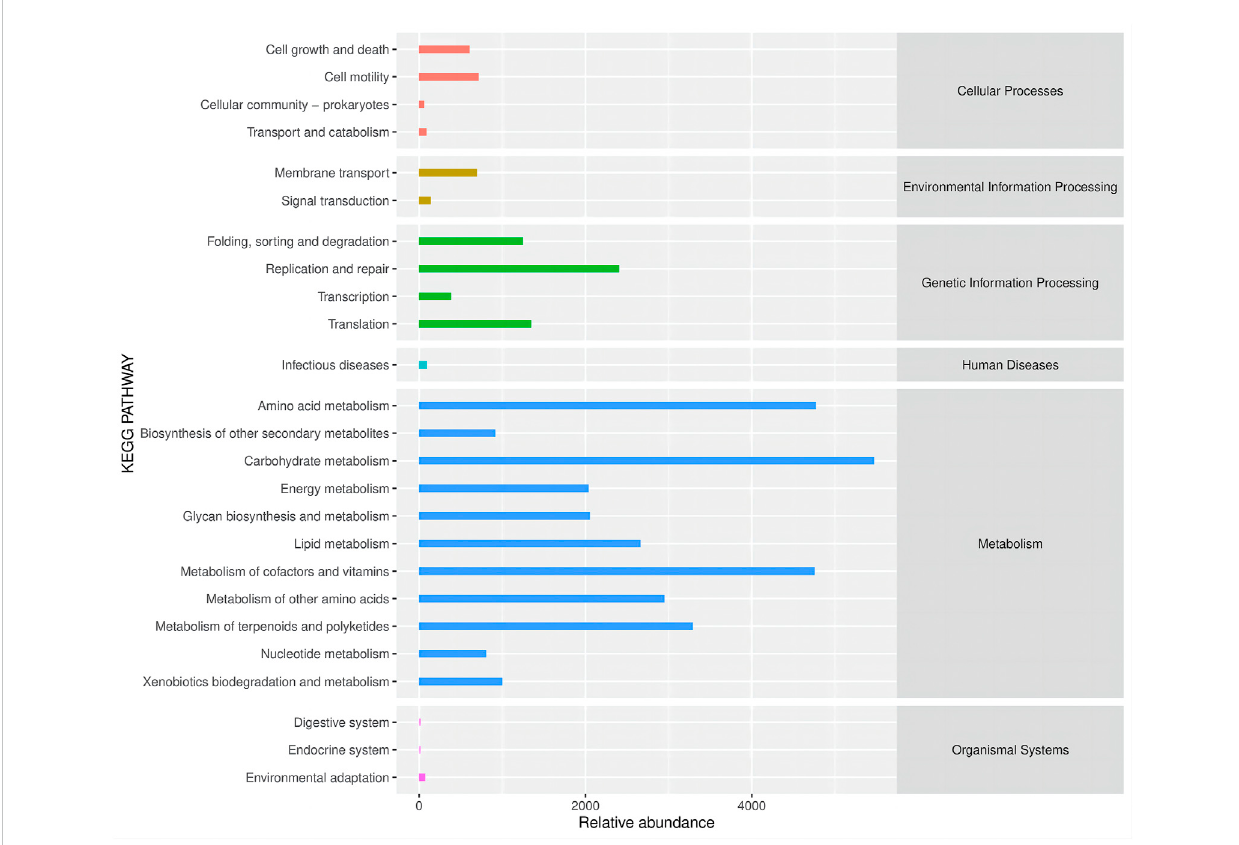
FIGURE 5 Secondary functional pathways and relative abundance of differential microbial enrichment in the KEGG Biometabolic Pathway Analysis database.